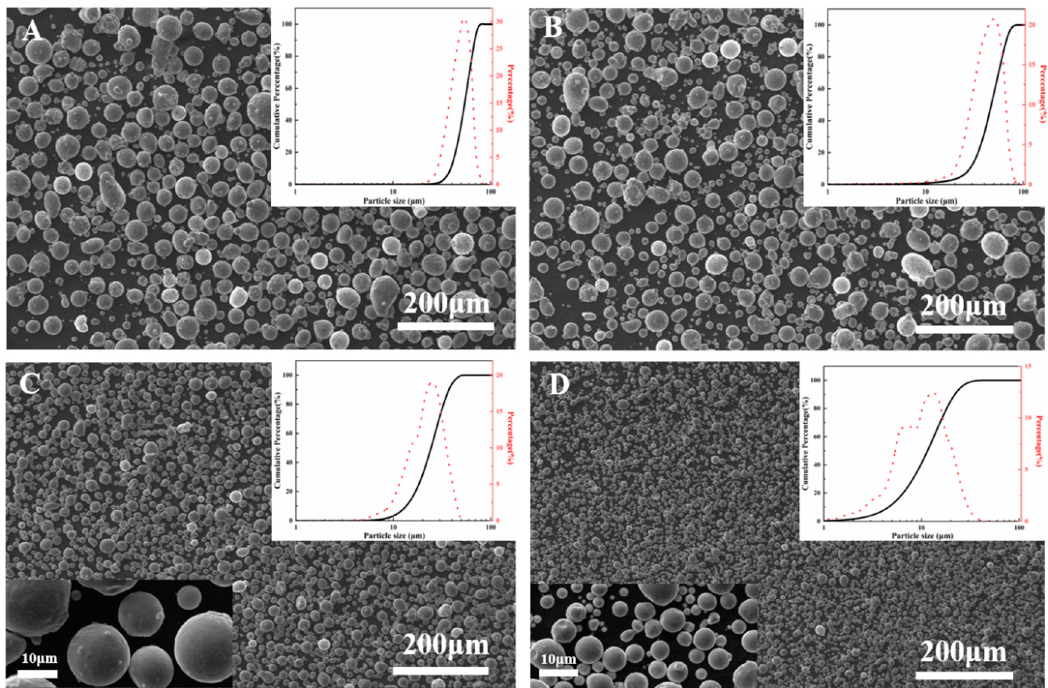
Figure 2. SEM images and particle size distributions of the Fe-6.5 wt%Si raw powders of ( A ) − 75 to +38 μ m, ( B ) − 38 to +23 μ m, ( C ) − 23 to +13 μ m, and ( D ) − 13 μ m. The insets are enlarged images of C and D.